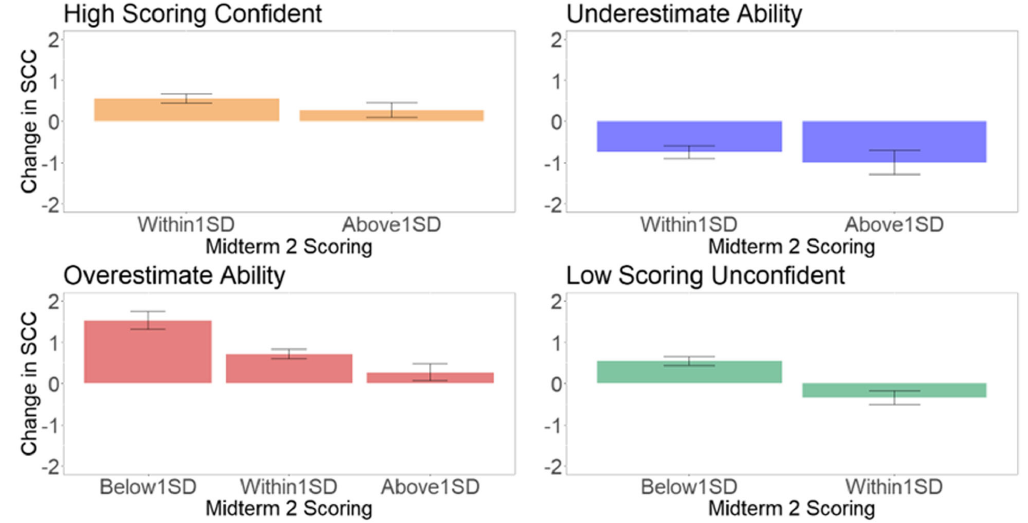
FIG. 6. The mean change in SCC versus midterm 2 scoring above, below, or within 1 standard deviation of the class mean score, for four initial state groups. Error bars are 1 SE.